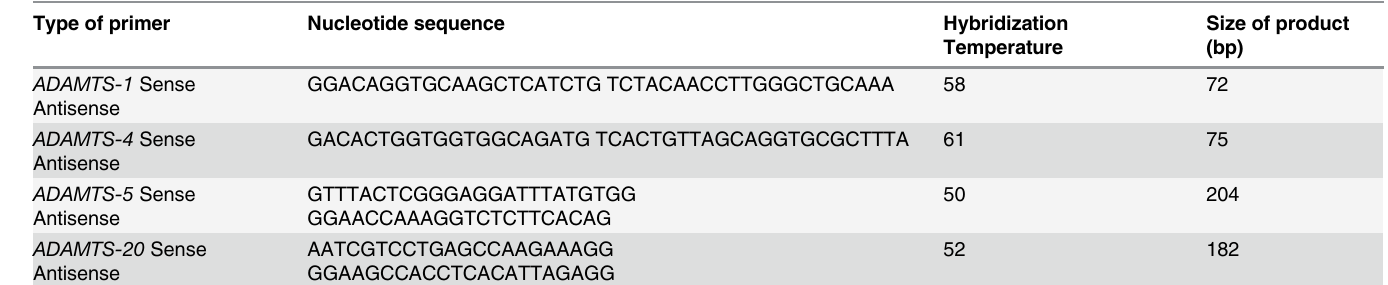
Table 1. Nucleotide sequence of the primers and Hybridization Temperature for each primer set used in RT-PCR experiments. Type of